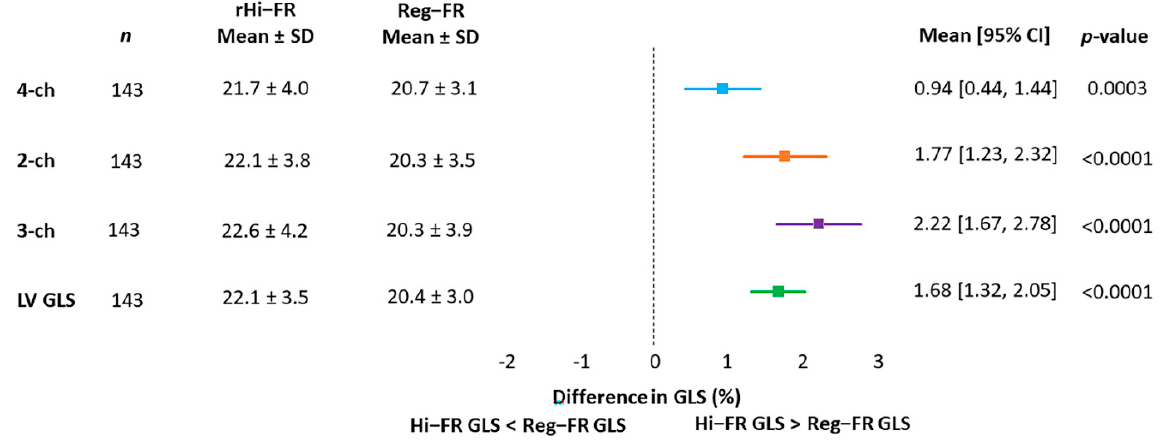
Figure 2. Forest plot showing difference in absolute GLS values measured in rHi-FR vs. Reg-FR. GLS, global longitudinal strain; rHi-FR, relatively high frame rate; LVEF, left ventricular ejection fraction; Reg-FR, regular frame rate.